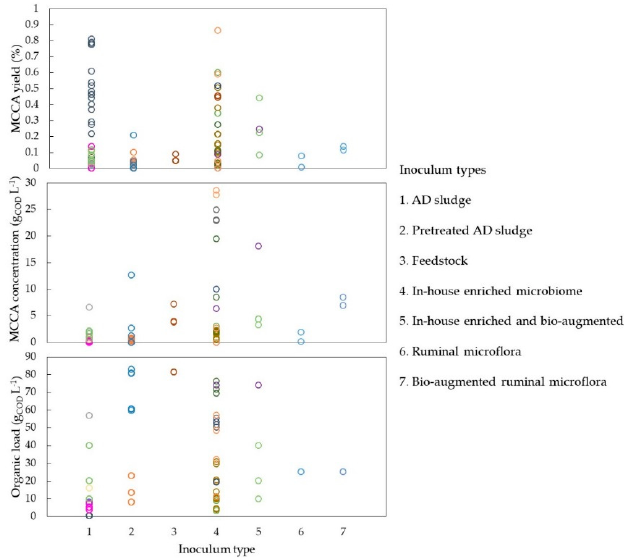
Figure 4. Inoculum type used in 17 studies performing batch experiments of complex or synthetic feedstock in function of the obtained MCCA yield (top), MCCA concentration (middle), or organic load applied (bottom). Colours represent experimental results reported in the same study. Estimated values were calculated as reported in Appendix A. Data collected from [20,40,70,83,88,90,91,96,101,108, 122,126,148,157,161–163], the full data for the figure can be consulted in the following database